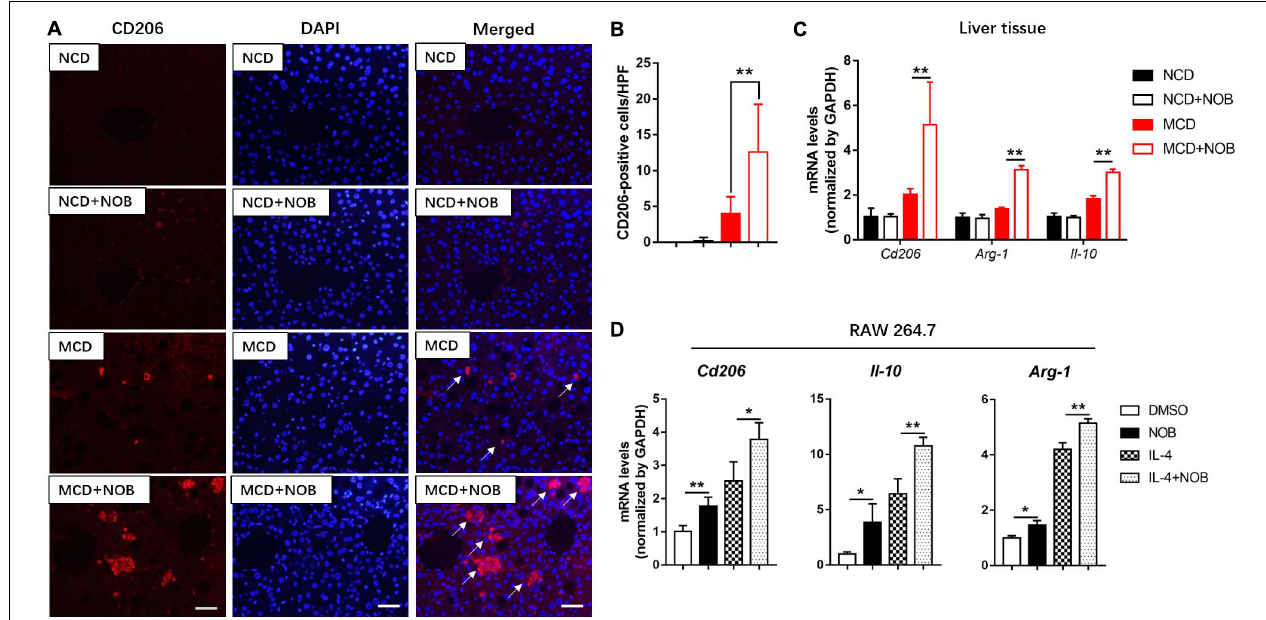
FIGURE 5 | The effect of NOB on M2 macrophage polarization and the expression of anti-inflammatory factors in liver tissue and RAW 264.7 cells. (A) Representative fluorescence microscopic images of CD206-stained liver sections. Scale bar = 300 µ m. (B) Quantification and statistical analysis of CD206-positive cells in liver tissue. We measured the number of CD206-positive membranes from at least five high power fields (HPF, original magnification, 400 × ). (C) The mRNA levels of Cd206 , Arg-1, and Il-10 in the livers of MCD-induced mice were evaluated using RT-qPCR. Data were expressed as the mean ± SD ( n = 5). (D) RAW 264.7 cells were pretreated with DMSO, NOB (100 µ M), LPS (200 ng/mL), or LPS (200 ng/mL) + NOB (100 µ M) for 16 h. The mRNA levels of Cd206 , Arg-1, and Il-10 were determined by RT-qPCR. Values are expressed as mean ± SD ( n = 3). * P < 0.05, ** P < 0.01.